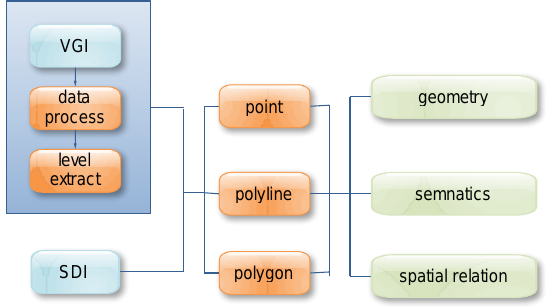
Figure 3. The matching of homonymous